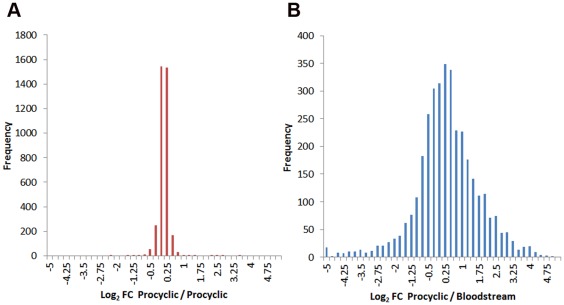
Histograms of Log2 fold change.
A. Procyclic form labeled with heavy isotopes (R6K6) mixed 1∶1 with unlabeled procyclic form (R0K0). B. Procyclic form labeled with heavy isotopes (R6K6) mixed 1∶1 with unlabeled bloodstream form (R0K0).